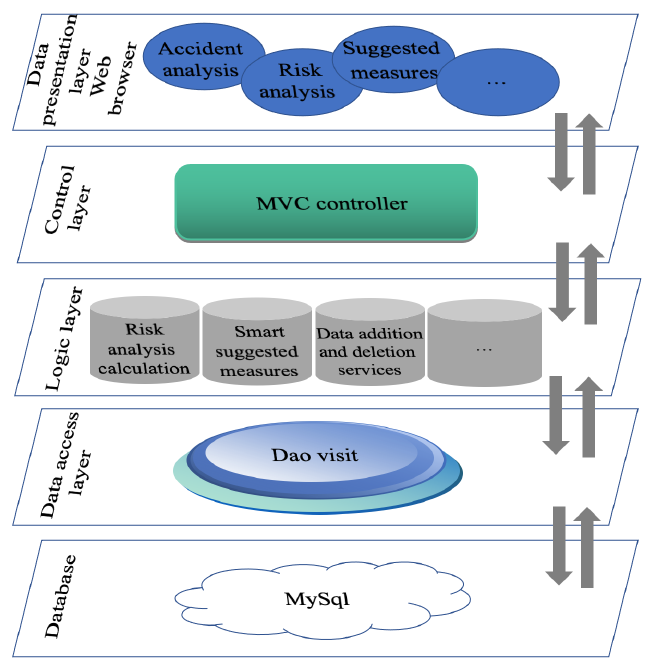
Figure 5. Technical framework of the risk assessment